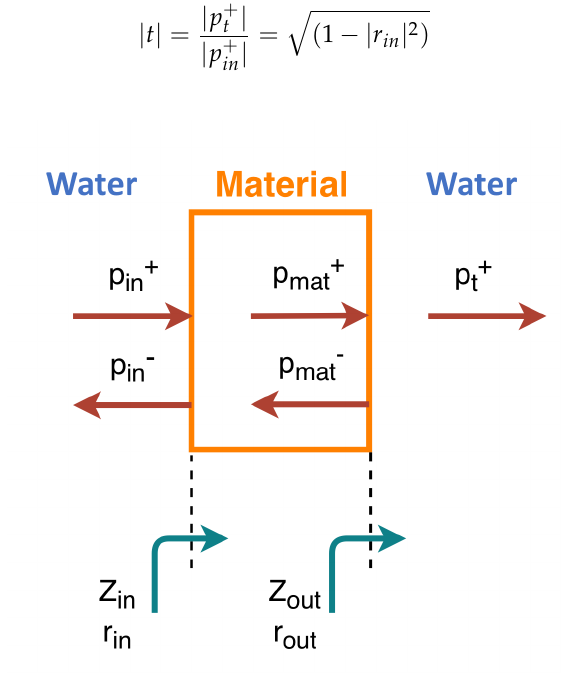
Figure 1. Transmission diagram of the implemented lenses. Table 1. Density and sound speed values. Acrylonitrile butadiene styrene (ABS), polylactic acid (PLA), and polymethyl methacrylate